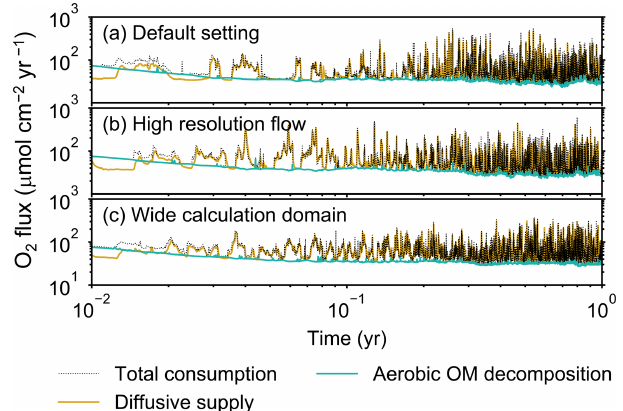
Figure B2. Time evolution of oxygen fluxes in simulations (a) with the default settings, (b) assuming a higher resolution (480 × 480) for the water flow calculation with otherwise default settings, and (c) assuming a wider calculation domain (24 × 12cm 2 ) and two deposit feeders with otherwise default settings. Only the absolute flux values of diffusive oxygen supply, aerobic decomposition of OM, and total oxygen consumption are shown.